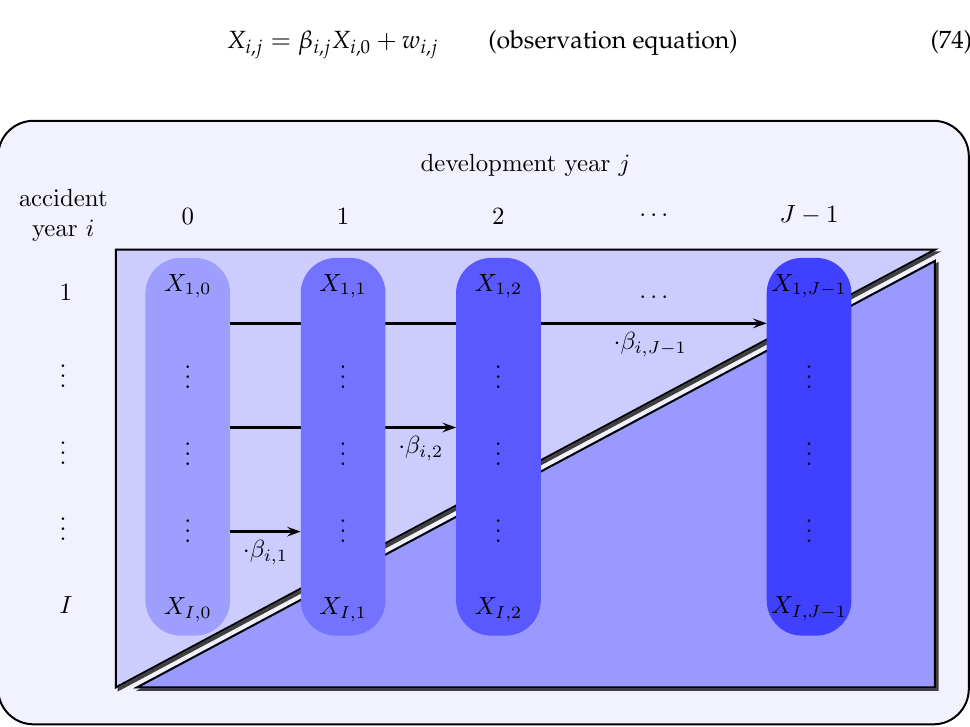
Figure 8. Modeling of the incremental payments in the work of Alpuim and Ribeiro (2003). Here, the incremental payments X i , j act as observations, while the β i , j for all i , j correspond to the unknown states. The state equation is constructed as an AR(1) model with the expected value µ j and β i , j as a function of β i 1, j −